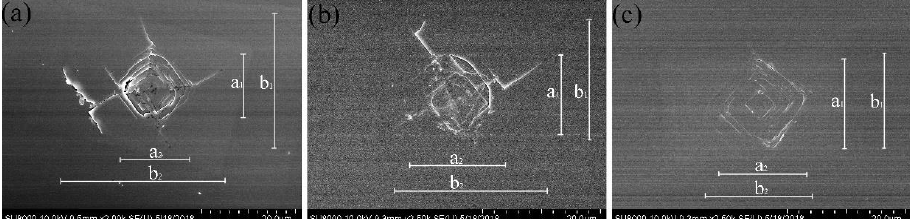
Table 2. Vickers hardness and fracture toughness of different